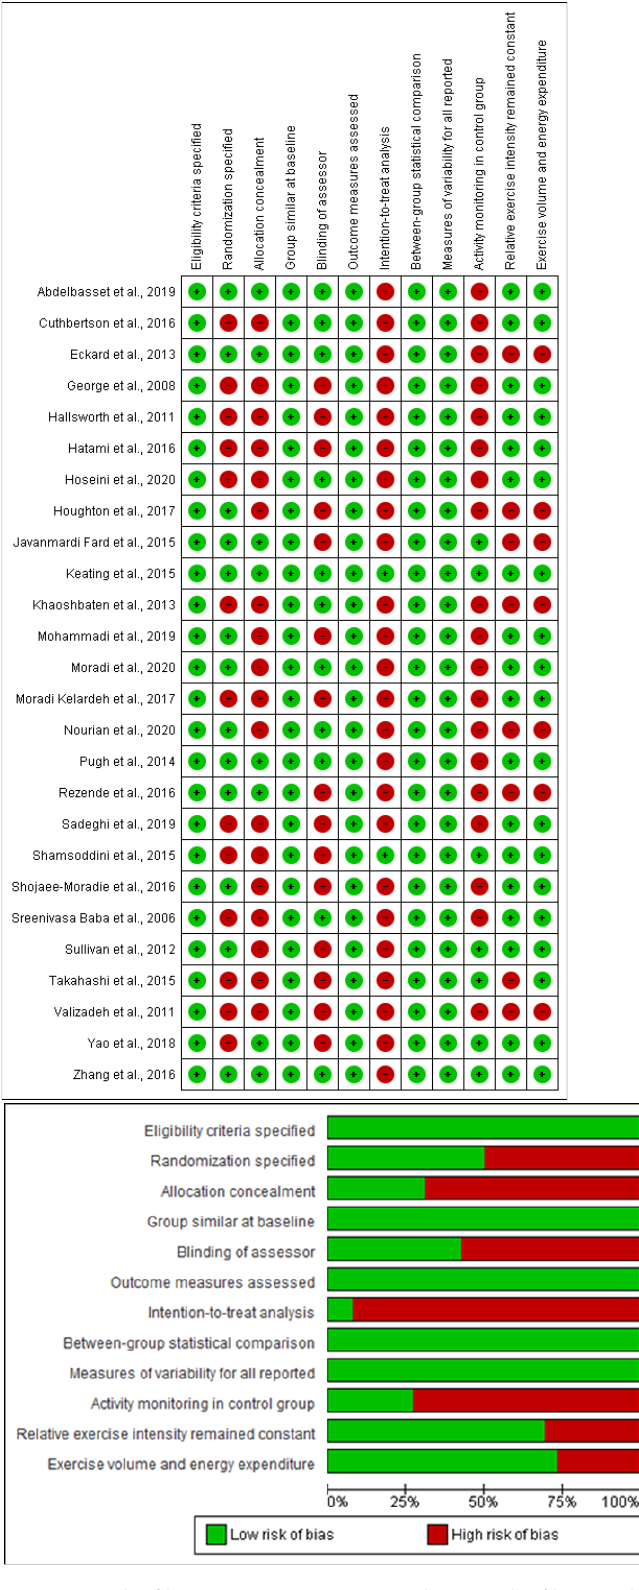
Figure 7. Risk of bias assessment using Cochrane risk of bias tool. Top panel—Risk of bias summary showing review author’s judgment about each risk of bias item for each included study. Bottom panel—Risk of bias graph showing review author’s judgment about each risk of bias item presented as percentages across all included studies [26,28–52].